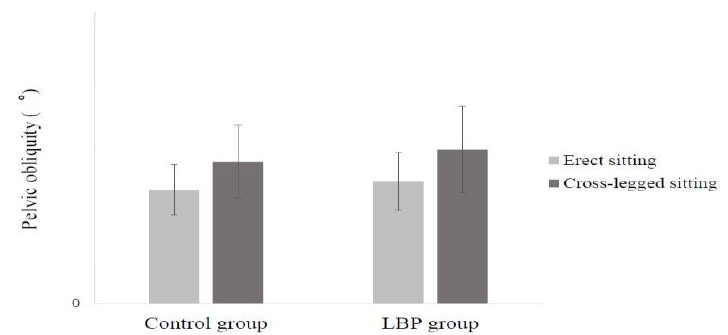
Figure 3. Mean (standard deviation) of pelvic obliquity during two different sitting postures.